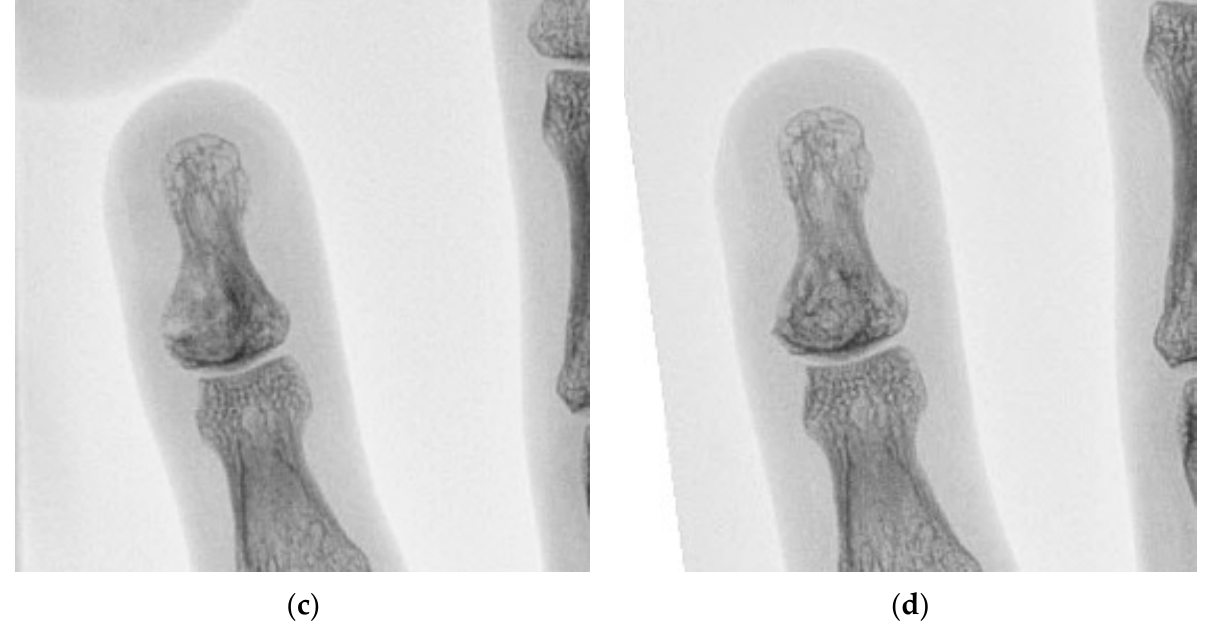
Figure 3. Posteroanterior (PA) radiographs of left little finger distal phalanx ( Case 5 ): ( a ) preoperatively, showing an enchondroma at the base of P3; ( b ) immediately postoperatively, following excision and curettage, with the contained defect filled with GeneX; ( c ) at 6 months follow-up, the GeneX shows partial resorption and there is some evidence of bone healing; and ( d ) at 12 months follow-up, the GeneX has been completely resorbed and the affected cortex has largely remodelled.